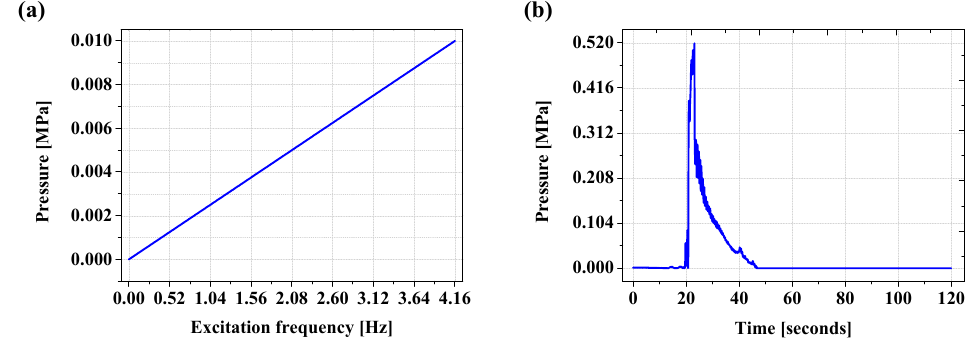
Figure 8. Load profiles: ( a ) For frequency response analysis, ( b ) For transient analysis.